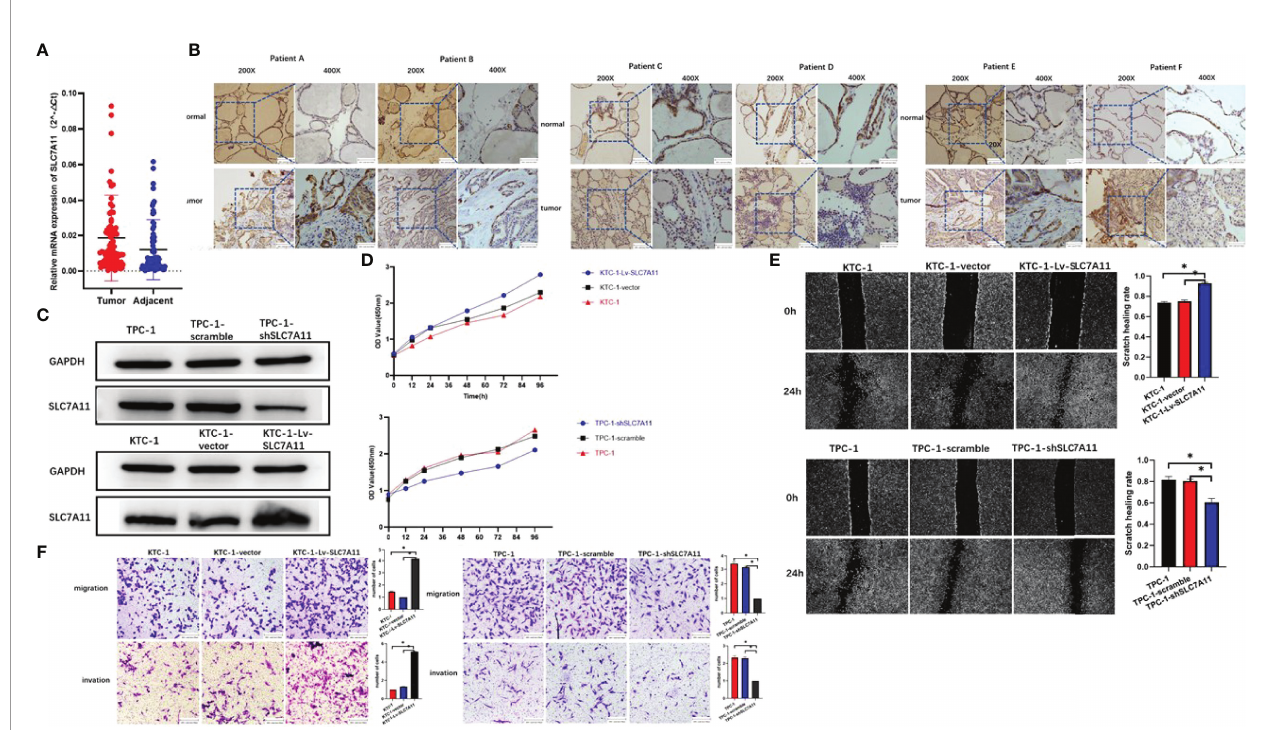
FIGURE 6 | SLC7A11 is identi fi ed as an oncogenic driver in papillary thyroid carcinoma (PTC). (A) Expression of SLC7A11 in 86 pairs of PTC specimens as determined by RT-qPCR. (B) Representative images of immunohistochemistry staining for SLC7A11 in specimens from patients with PTC. (C) SLC7A11 protein expression in control and KTC-1-Lv-SLC7A11/TPC-1-shSLC7A11 cells was assessed by western blot. (D) CCK-8 assays to analyze cell viability in control and KTC- 1-Lv-SLC7A11 and TPC-1-shSLC7A11 cells. (E) Scratch assay. SLC7A11 knockdown signi fi cantly increased PTC cell death and attenuated the migration ability in vitro . (F) In vitro migration and invasion of control and KTC-1-Lv-SLC7A11/TPC-1-shSLC7A11 cells as assessed by transwell assay. *,